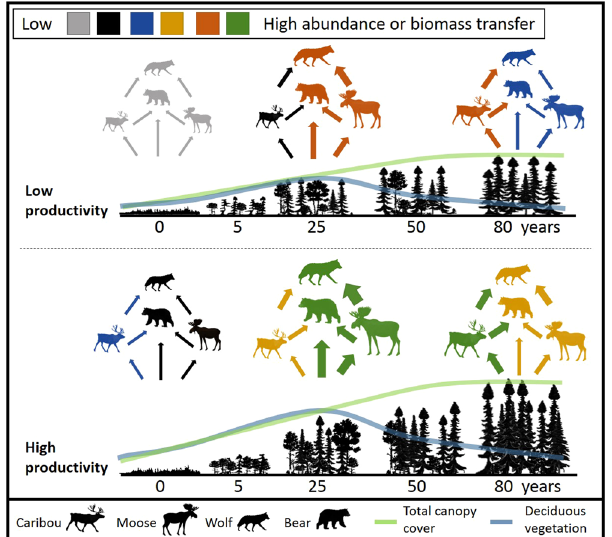
Figure 4. Changes in forest stand characteristics during the first 80 years of secondary succession in eastern Canadian boreal forest, together with a potential scenario of changes in trophic interactions that is consistent with the higher growth of caribou populations observed in more productive boreal forests. Change in animal size reflects how the abundance of a given species varies over time, whereas arrow size is proportional to trophic interaction strength. The illustration indicates that in 25-year-old stands, moose have access to more deciduous vegetation in high than low productivity forests, which results in higher moose density in landscape largely comprised of these stands, and subsequently in higher grey wolf density. Likewise, black bears have access to more grasses, forbs and berries in 25-year-old stands found in more productive landscapes, thereby leading to high predation rates on calves and, therefore, to relatively low recruitment in productive forests that are largely comprised of these early-seral stands. Ultimately, the faster succession towards relatively safe forests that are largely comprised closed-canopy conifer stands would be largely responsible for the relatively high growth of boreal caribou population in high- than low-productive